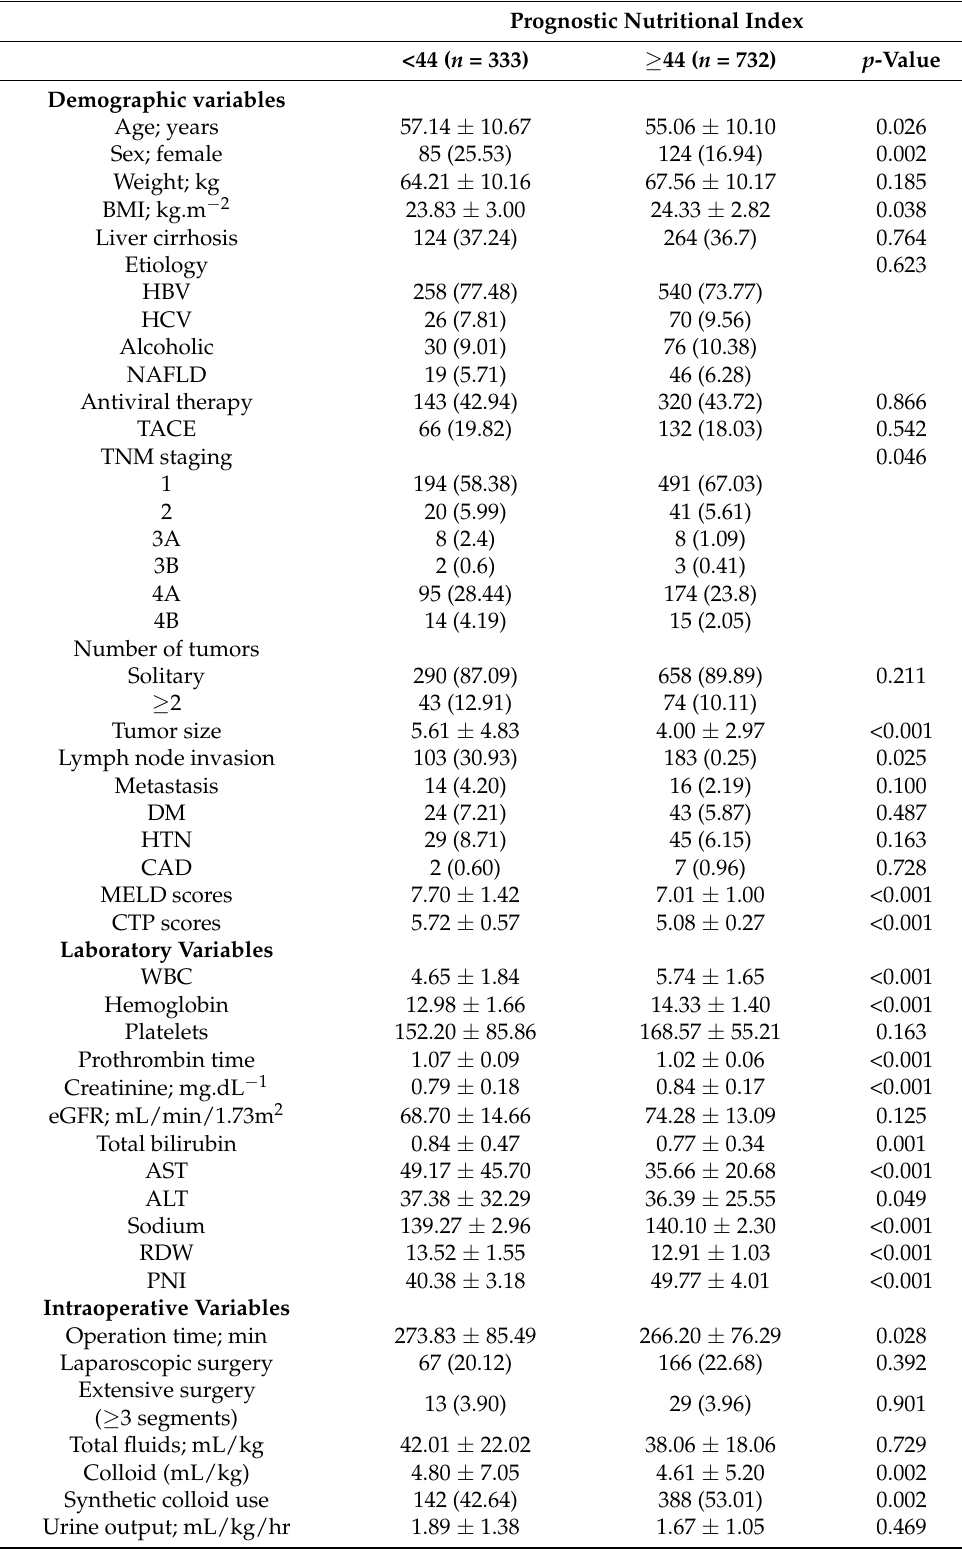
Table 1. Demographic, laboratory, and intraoperative variables, and surgical outcomes of the study